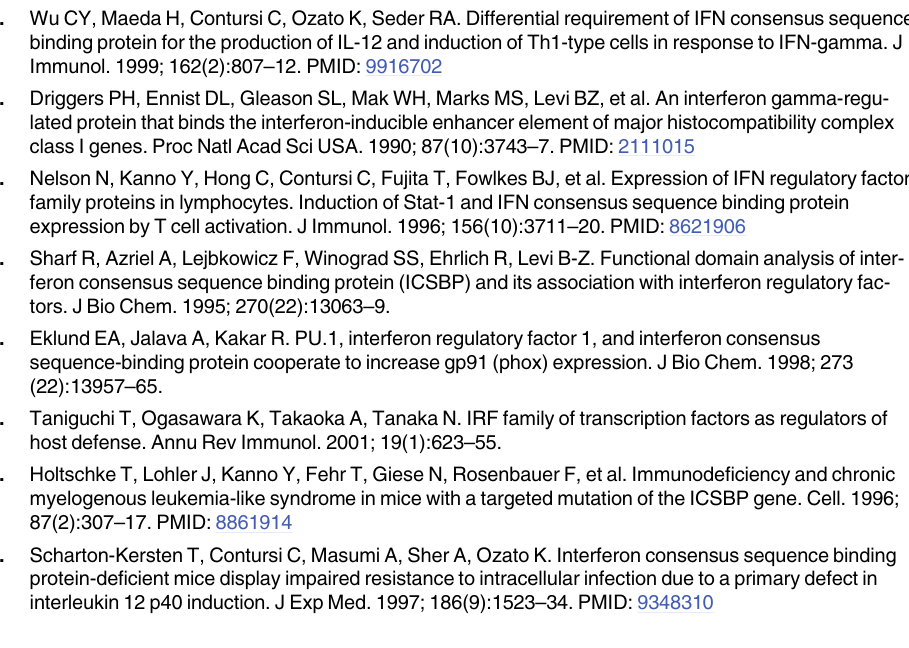
S6 Fig. TGF β levels in the supernatants of MLN cells stimulated ex vivo with AWH. (PDF) S7 Fig. Effects of MDSC and Treg depletion in Hpb-infected Irf8 -/- mice on Th2 immune responses and infection